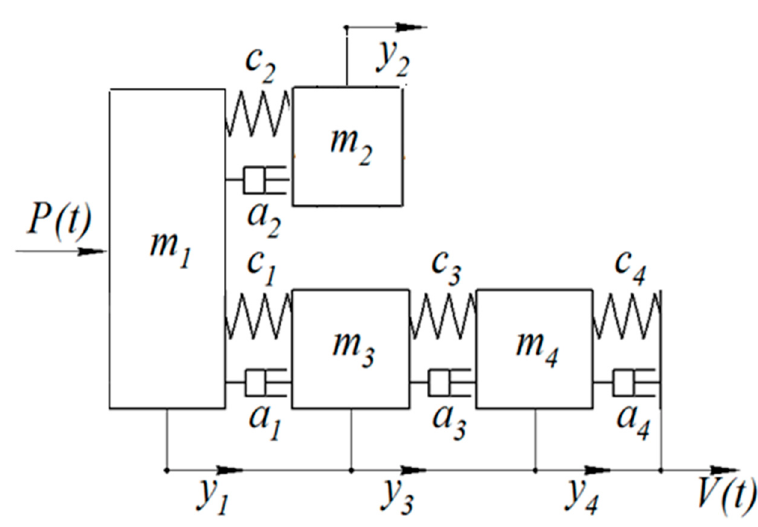
Figure 2. The designed scheme.